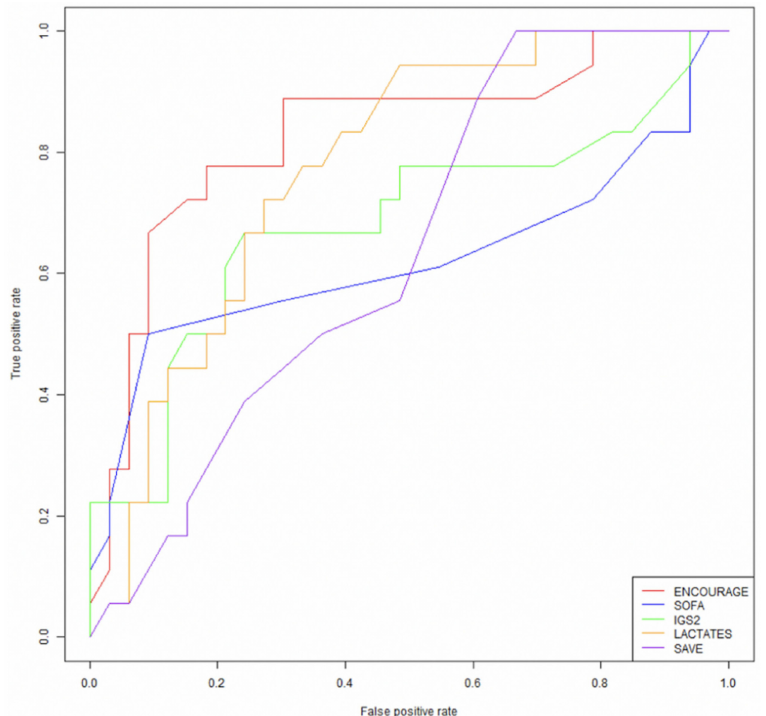
Figure 2. Receiving Operating Characteristic (ROC) curve of the prEdictioN of Cardiogenic shock OUtcome foR AMI patients salvaGed by VA-ECMO (ENCOURAGE), Sequential Organ Failure Assessment (SOFA), Simplified Acute Physiology Score II/Indice de Gravit é Simplifi é (SAPS II/IGS2), lactate, and Survival After Veno-arterial ECMO (SAVE) scores to predict the 30-day mortality.